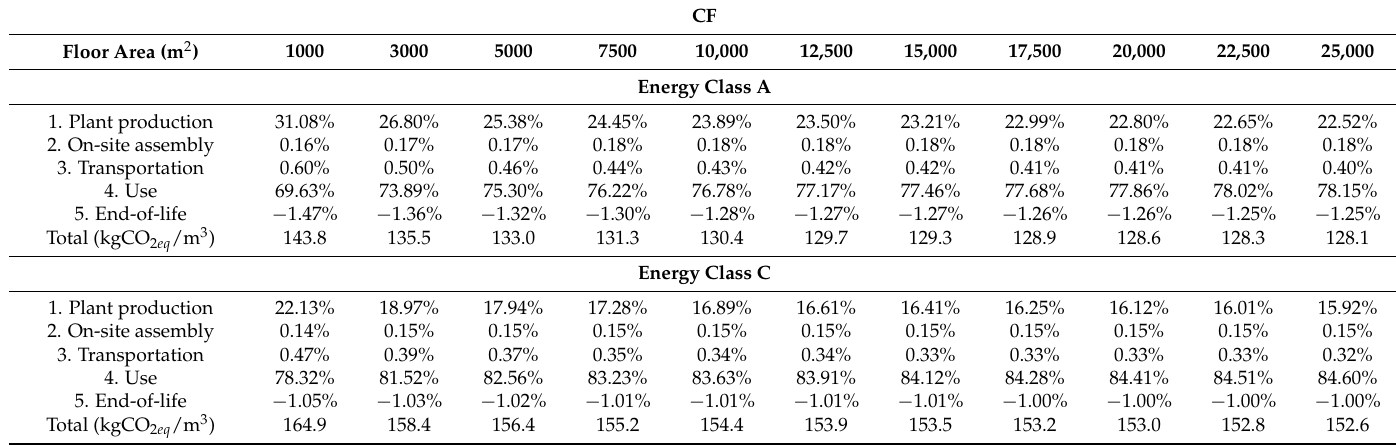
Table 6. CF: enhanced vs . standard insulation.